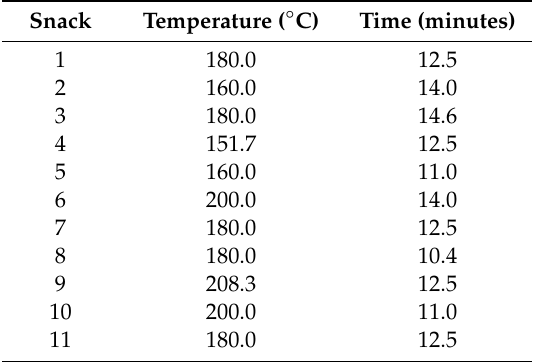
Table 2. Response surface methodology (RSM) with a face-centered rotational composite experimental